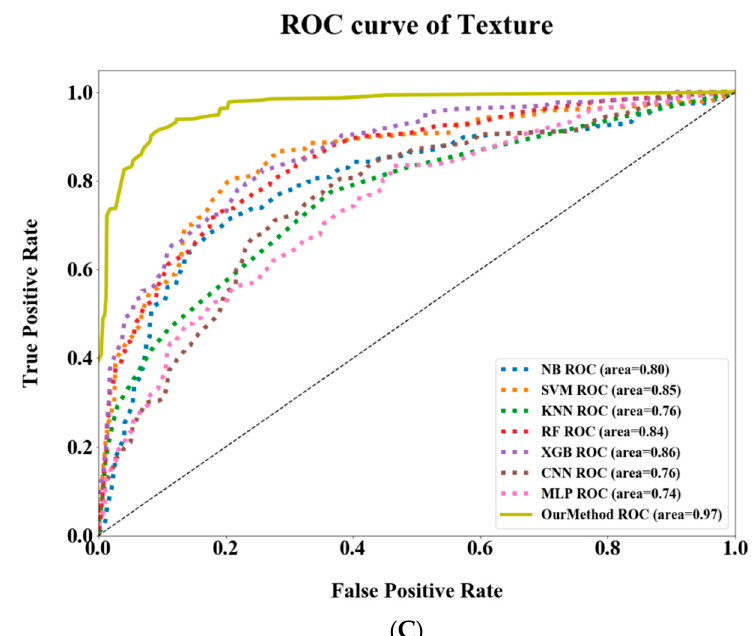
Figure 3. ROC Curves of the CT2Rep and compared methods for three semantic features: ( A ) Location, ( B ) Margin, and ( C ) Texture. The ROC curves with AUC include 8 approaches for predicting semantic features. The horizontal axis of these plots is the False Positive Rate, which also stands for probability of false alarm, whereas the vertical axis is True Positive Rate, which also stands for sensitivity.